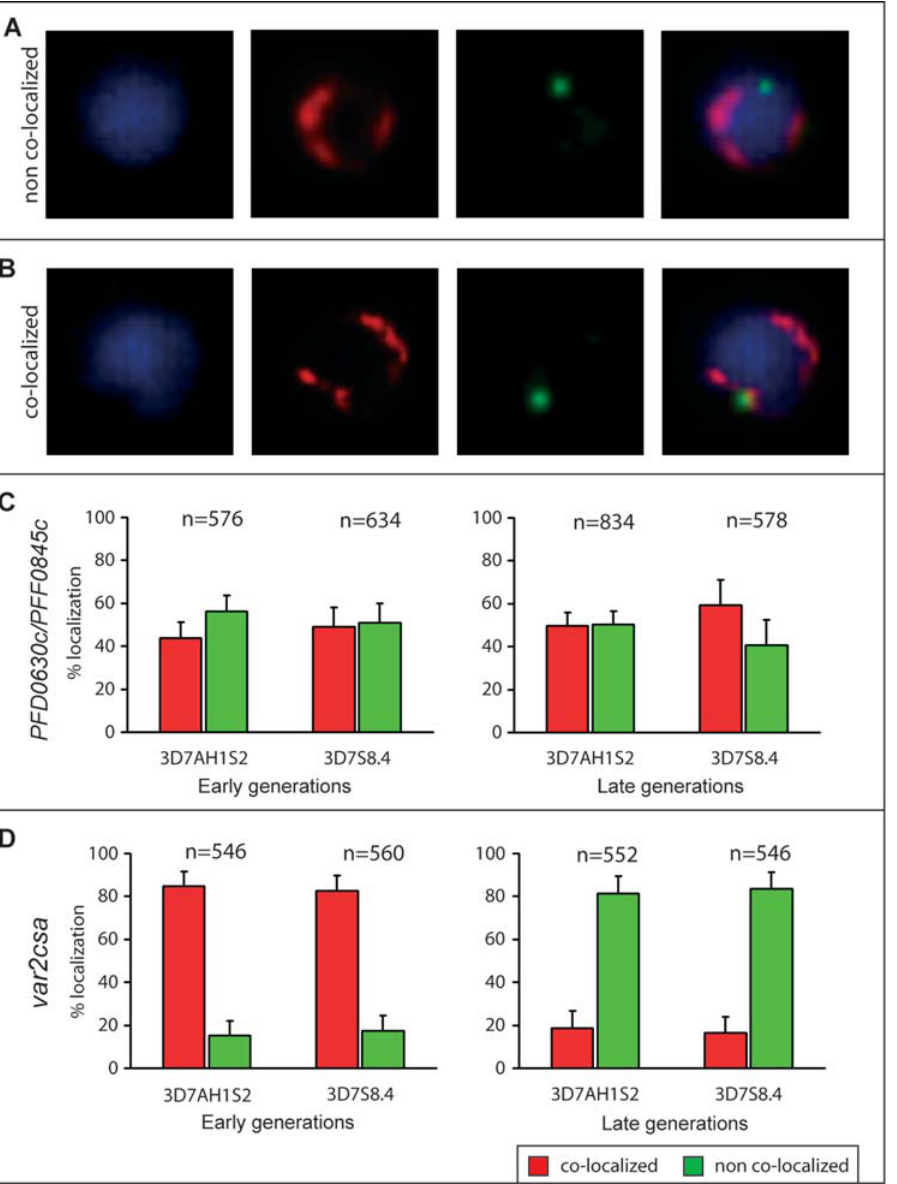
Figure 6. Repositioning of var -genes in the peri-nuclear area as seen by FISH in P.falciparum 3D7S8.4 and 3D7AH1S2 ring-stage parasites at onset and after 200 generations of invitro growth. (A & B) Representative pictures illustrate different localization patterns of telomeric clusters (rep20, red probe) compared with that of a var -gene (green probe) in nuclei stained with DAPI (blue). Telomeric clusters appear as horseshoe-like bundles where condensed heterochromatins are located. (C) The var -genes expressed at the onset of the experiment (PFD0630c/ PFF0845c) did not reposition and did not show any correlation between their transcriptional states and peri-nuclear positions in the same parasites. (D) In contrast, in early generation parasites (15–21 generations) var2csa is in a silenced state and co-localizes with the telomeric clusters. After 194- 206 generations var2csa transcription is active in both parasites (3D7SS8.4, 3D7AH1S2) with a concordant repositioning from telomeric clusters to a zone without condensed genetic